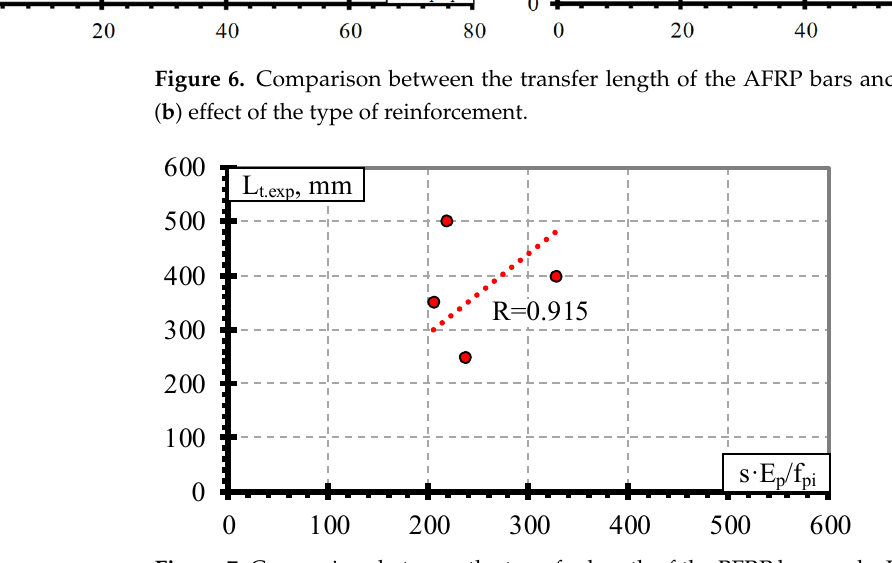
Figure 7. Comparison between the transfer length of the BFRP bars and s·E p /f pi. Table 4. Summary of the bond shape factor α